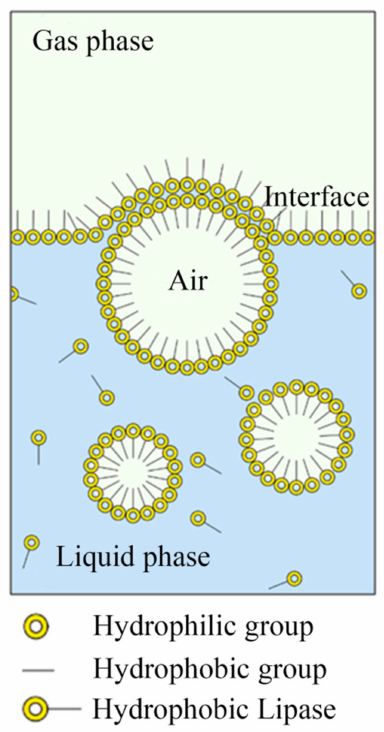
Figure 1. Adsorption of lipase B on the surface of